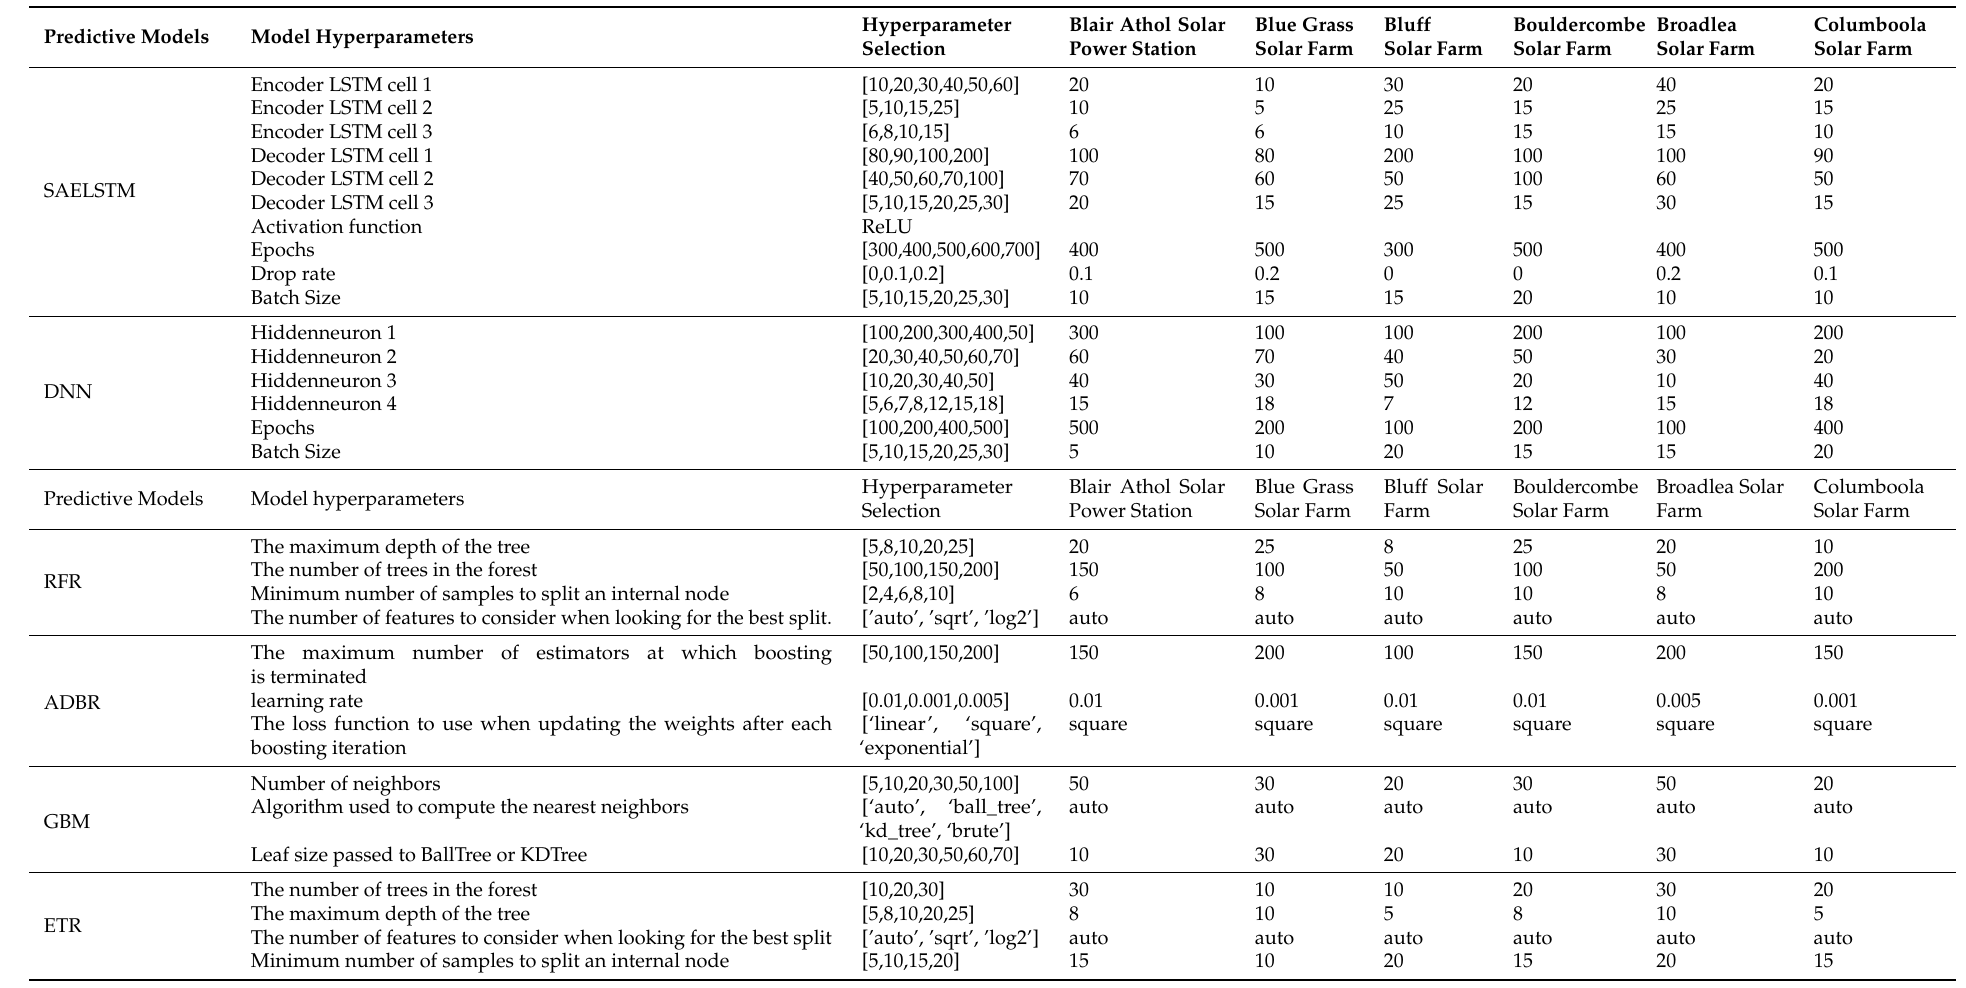
Table A1. (a) The proposed Deep Learning hybrid SAELSTM (i.e., stacked LSTM sequence-to-sequence autoencoder) and Deep Neural Network (DNN) models. (b) The comparison of machine learning models: Random Forest Regression (RFR), Adaboost Regression (ADBR), Gradient Boosting Machine (GBM), and Extremely Random Tree Regression (ETR). Note: ReLU = Rectified Linear